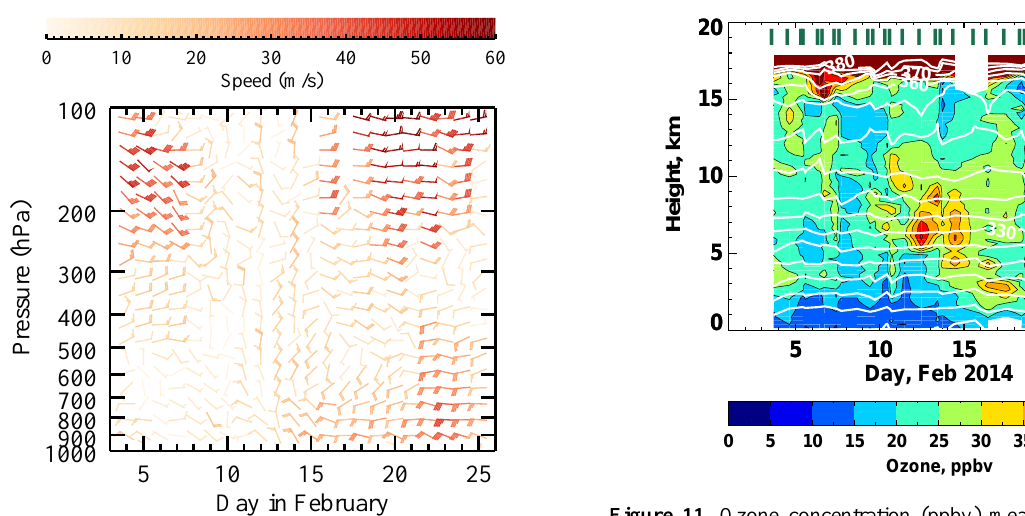
Figure 11. Ozone concentration (ppbv) measured by the CAST ozonesondes between 0 and 18km during February 2014, overlaid with potential temperature (K, white contours). Green bars at the top denote the launch times of individual